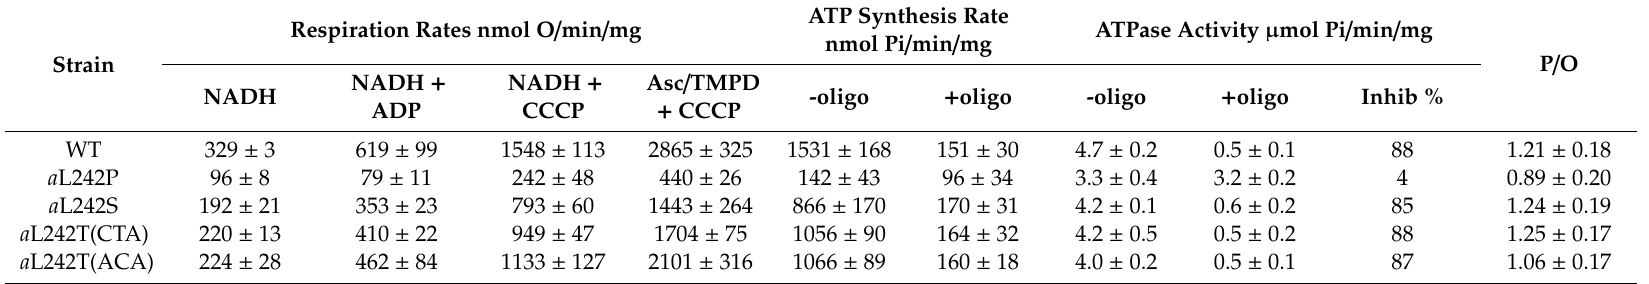
Table 2. Mitochondrial respiration and ATP synthesis /